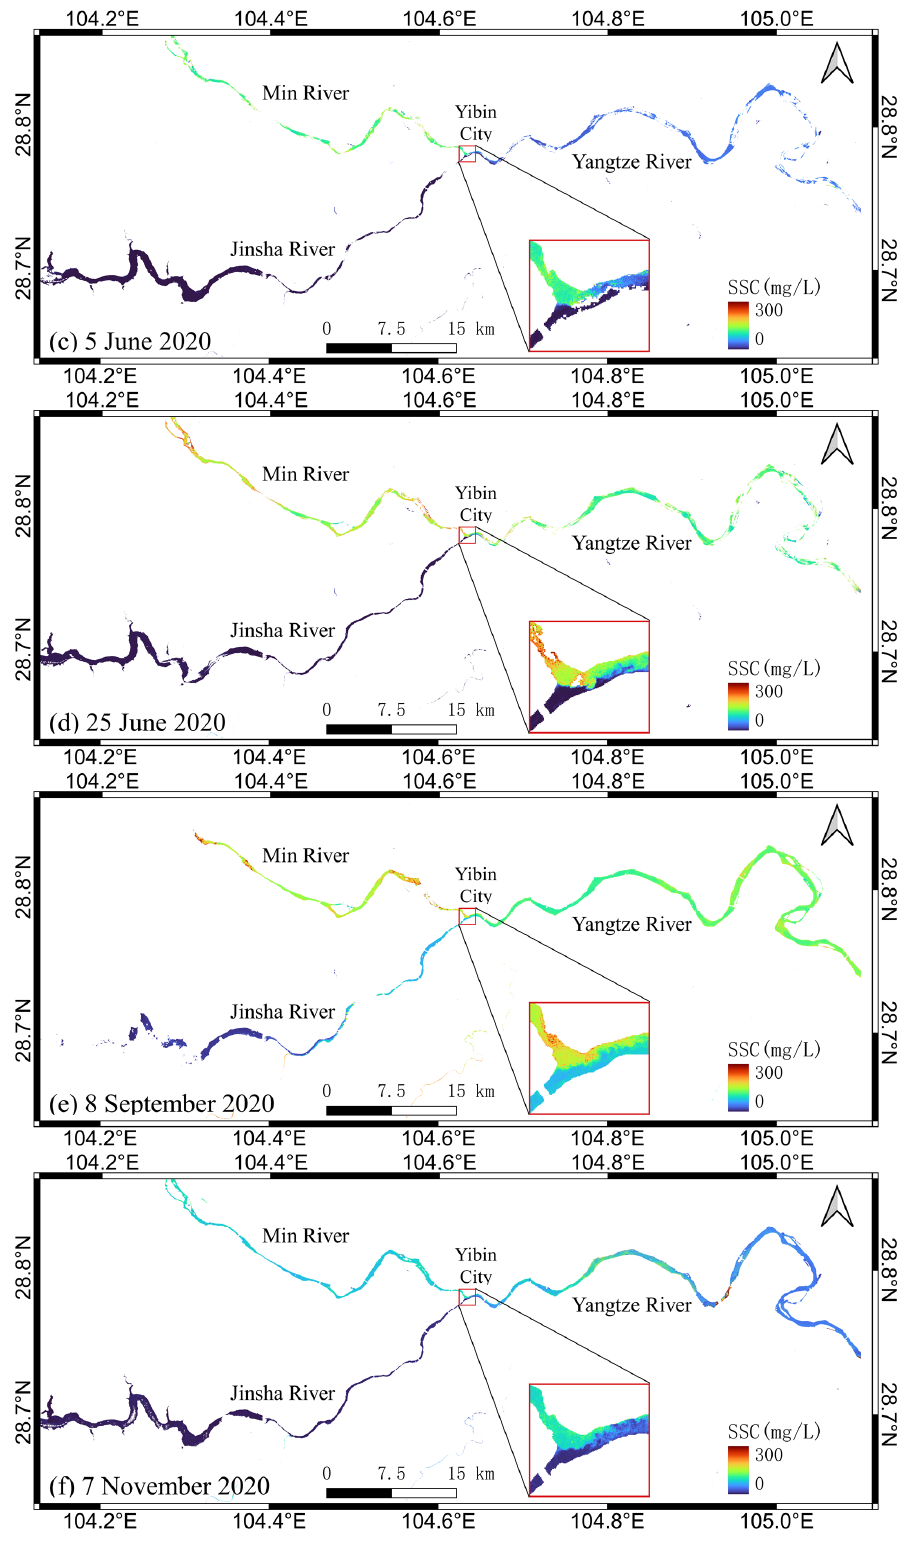
Figure 10. Spatiotemporal distributions of the retrieved SSC above and below the Yibin Reach. The expanded views in the red rectangles indicate the clear dividing line at the confluence. The Sentinel-2 MSI images were shot on: ( a ) 11 February 2020, ( b ) 22 March 2020, ( c ) 5 June 2020, ( d ) 25 June